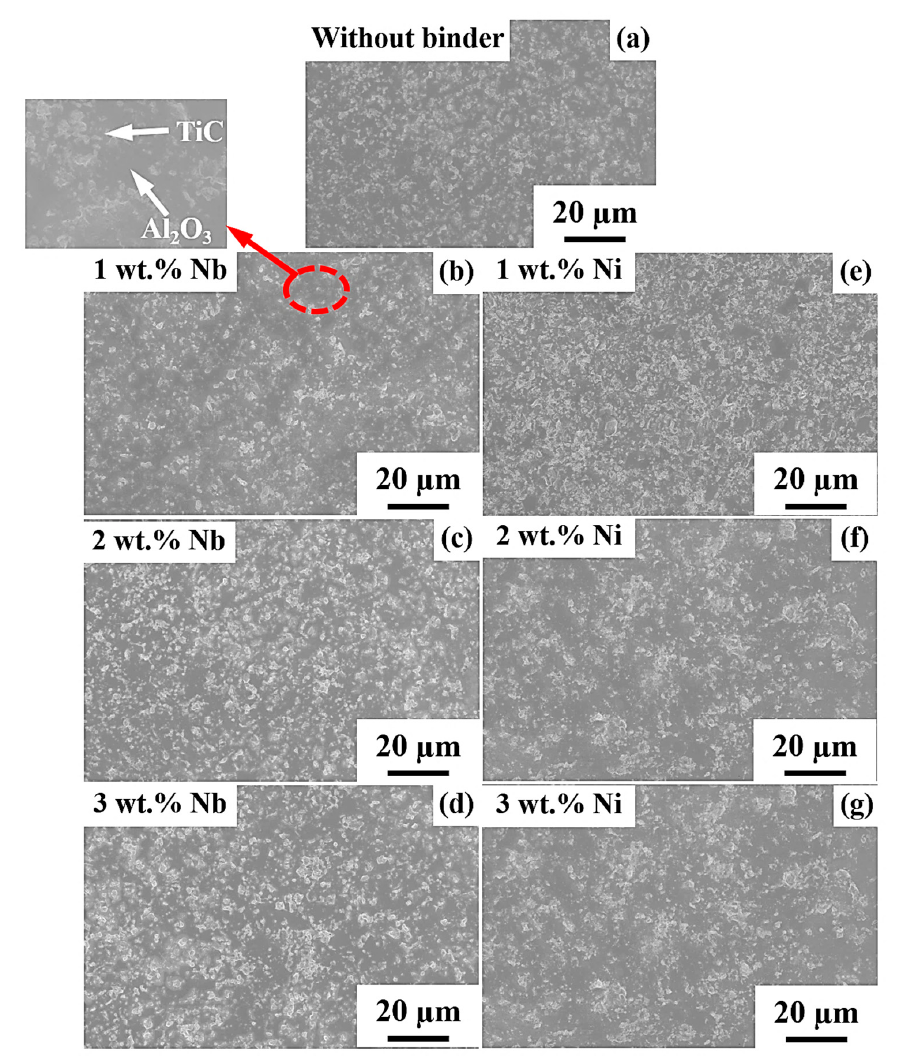
Figure 3. FESEM micrographs of the sintered Al 2 O 3 -TiC composite without binder ( a ) and with different contents (wt. %) of binder addition: Nb ( b – d ) and Ni ( e – g ).